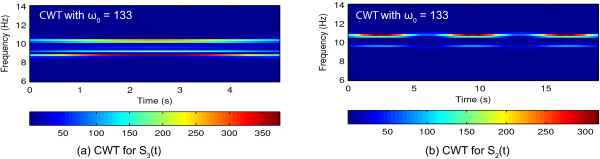
Modified CWT for synthetic signals S2(t) andS3(t).(a) Time-frequency mapping of CWT for S3(t) with ω0=133; (b) Time-frequency mapping of CWT for S2(t) with ω0=133.